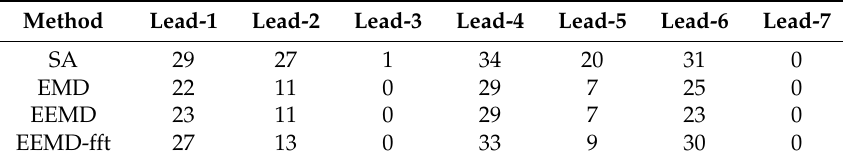
Table 4. Total clinical cases subject count which had a recognizable ECG waveform resulting after applying denoising methods (N = 34).